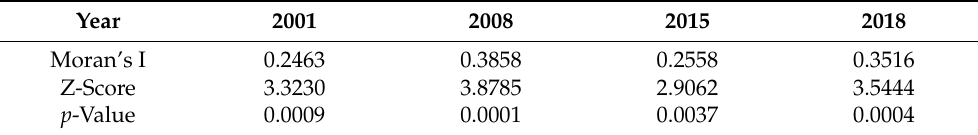
Table 1. Global Moran’s I of startups in the Yangtze River Delta from 2001 to